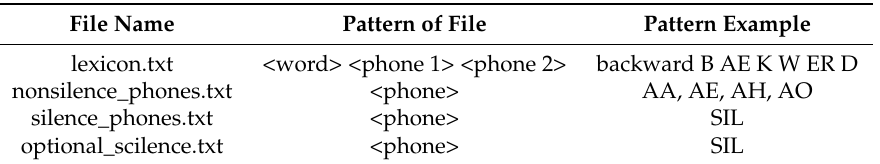
Table 1. Language data files.